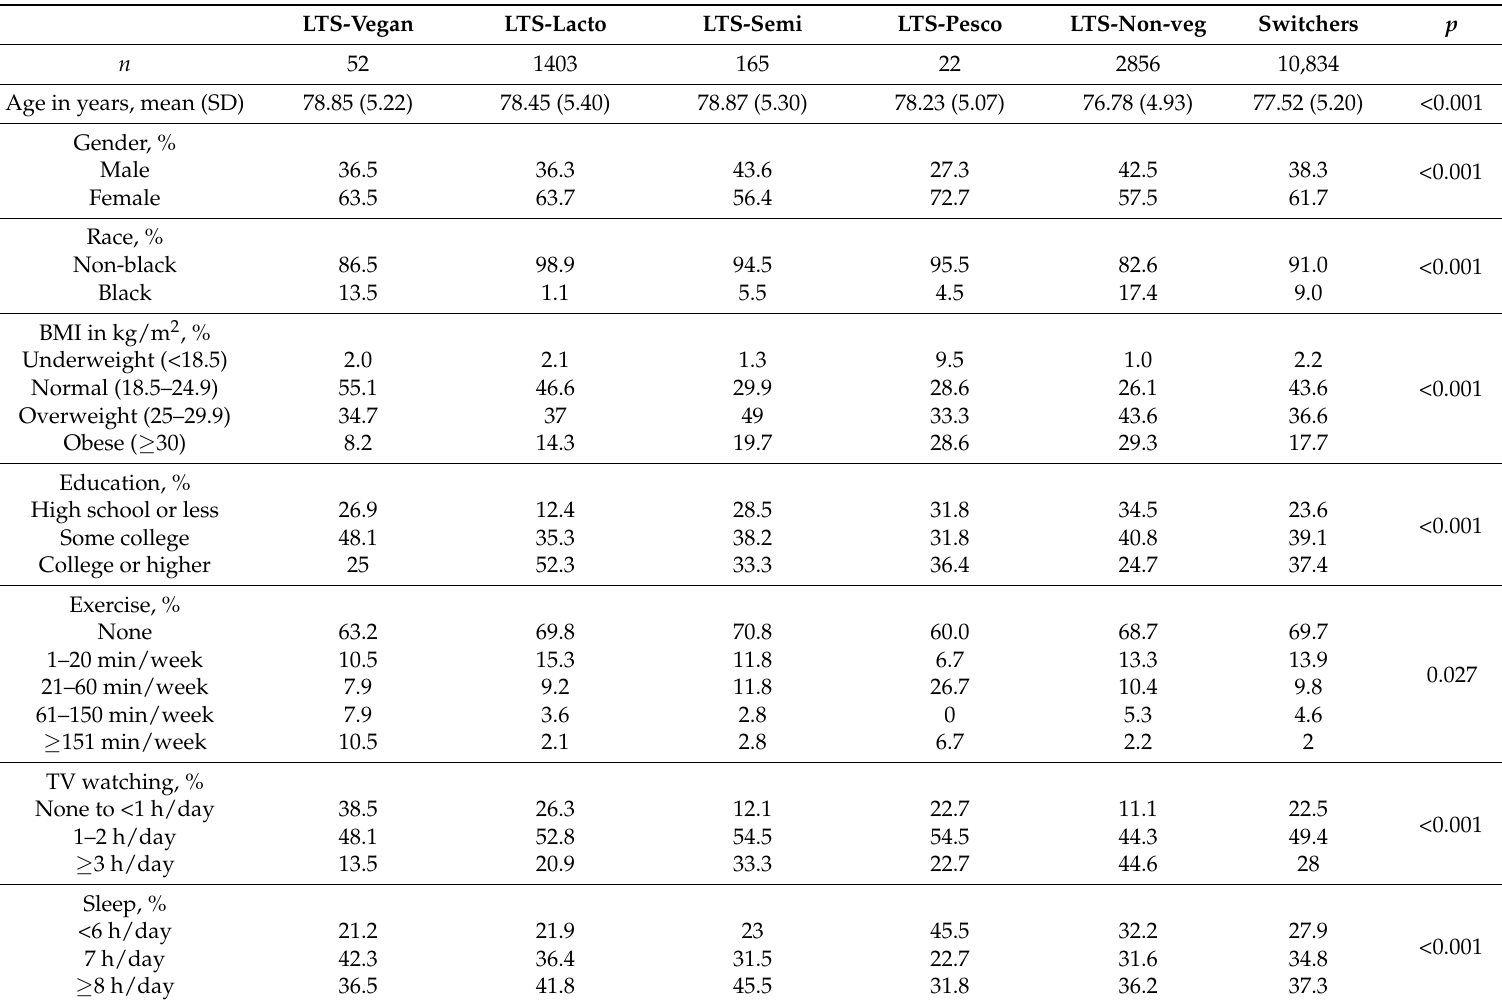
Table 1. Distribution of non-dietary variables among Adventists aged 70+ years who were lifetime-stable adherents to particular dietary patterns *. LTS-Vegan